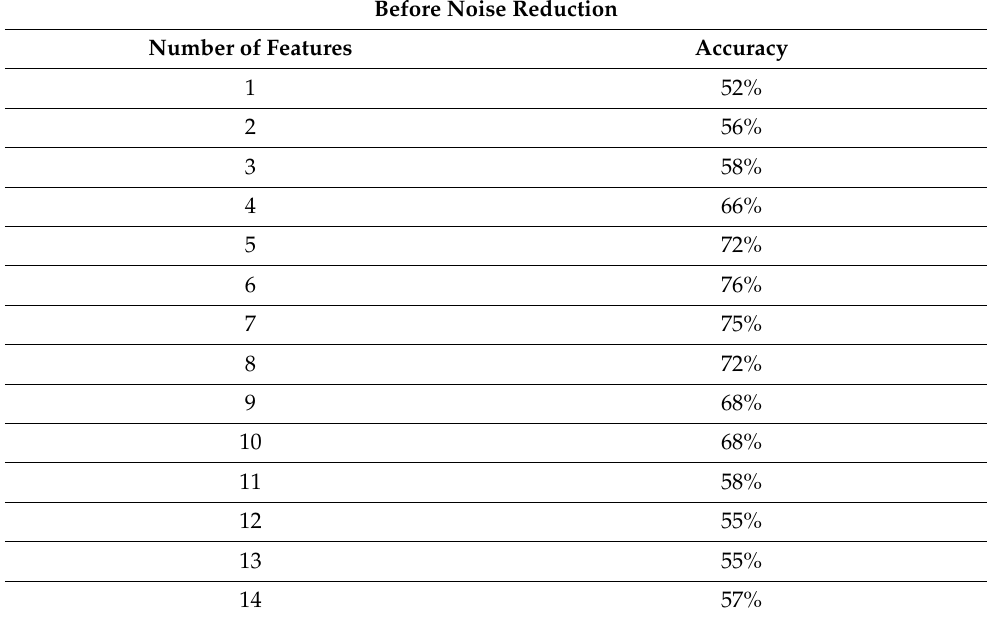
Table 3. Tool life cycle model